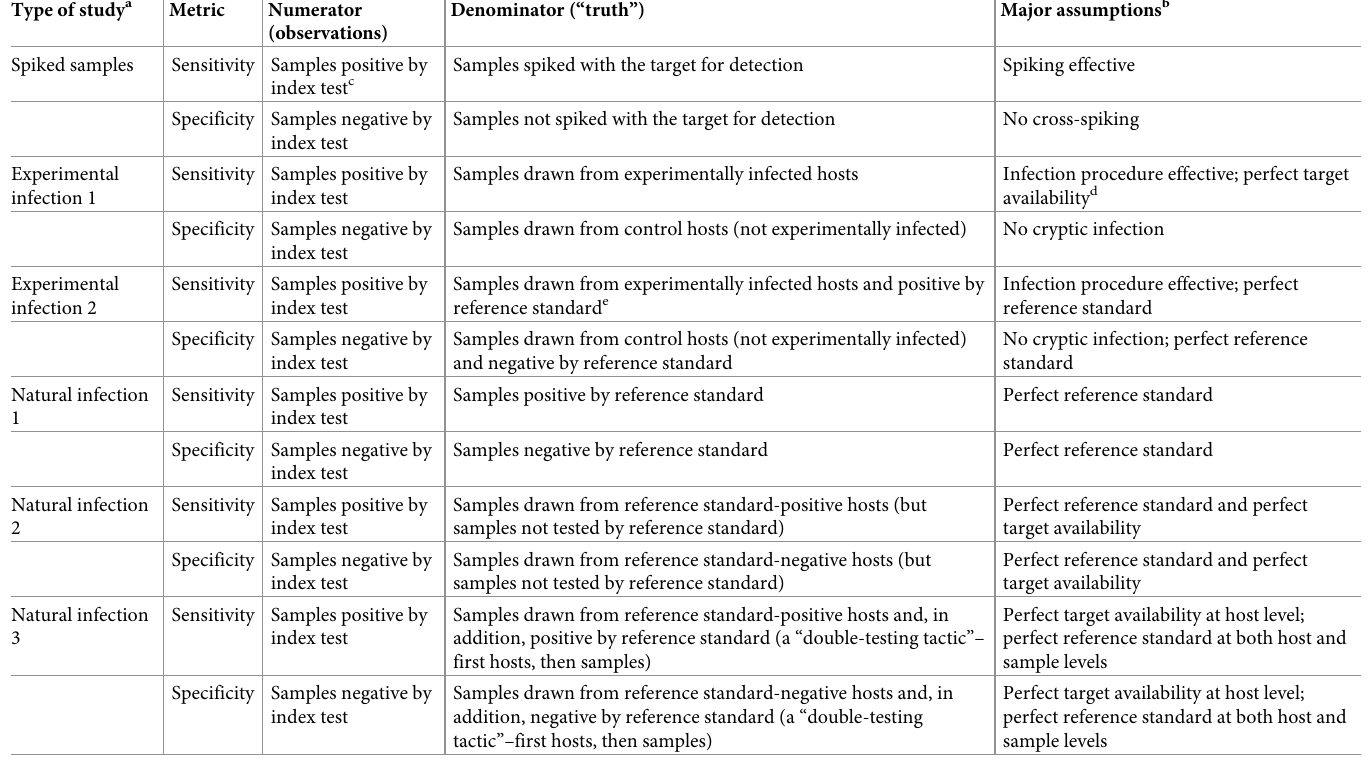
Table 1. Testing tests: In many common types of diagnostic test-performance studies, the two key performance metrics (sensitivity and specificity) are computed using different denominators and under different, seldom explicit